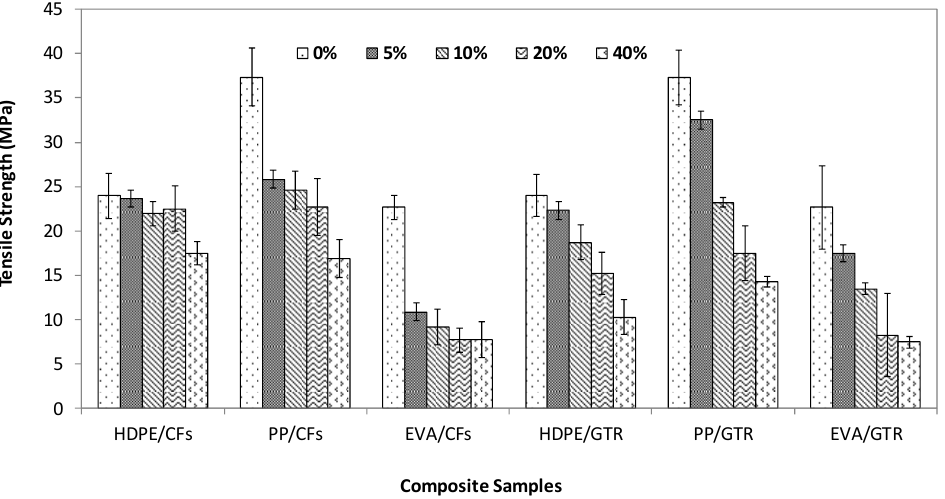
Figure 1. Tensile strength of the polymeric composites at compositions between 0 and 40% w / w .